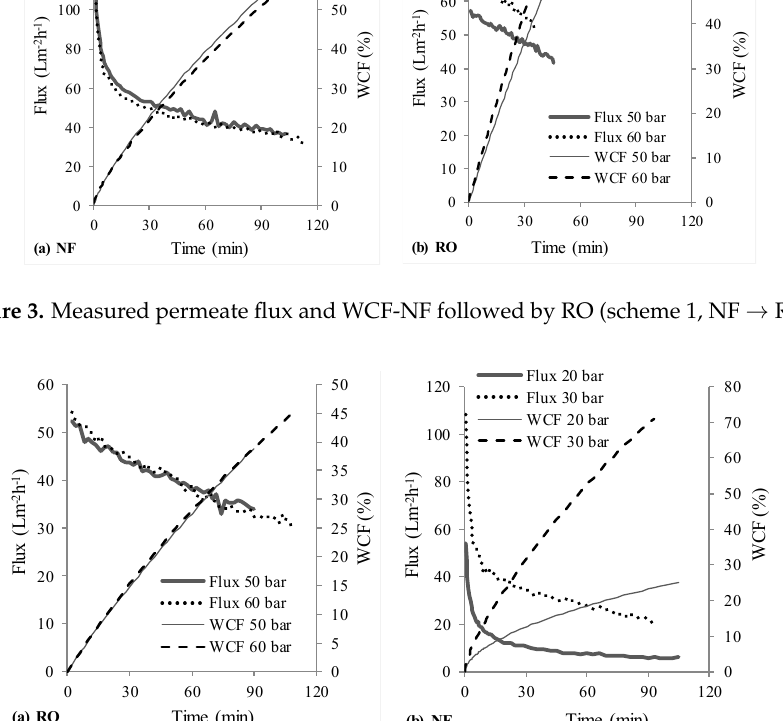
Figure 4. Measured permeate flux and WCF-RO followed by NF (scheme 2, RO → NF).